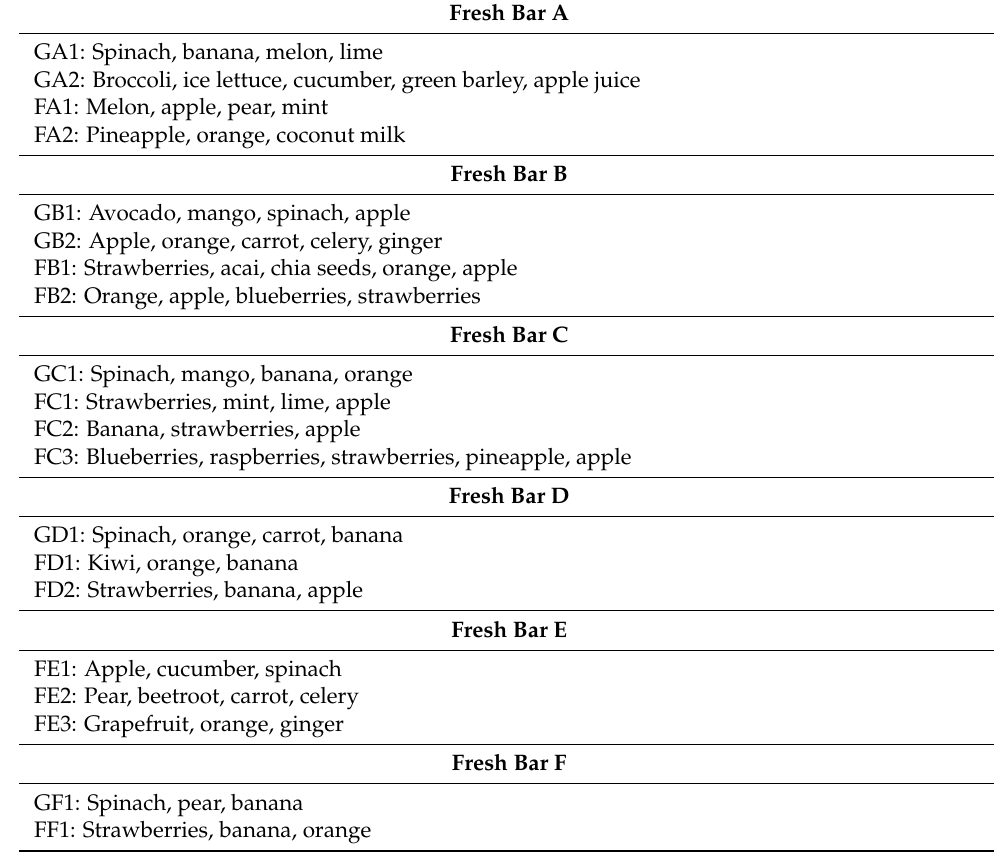
Table 1. Name and composition of the analyzed smoothie